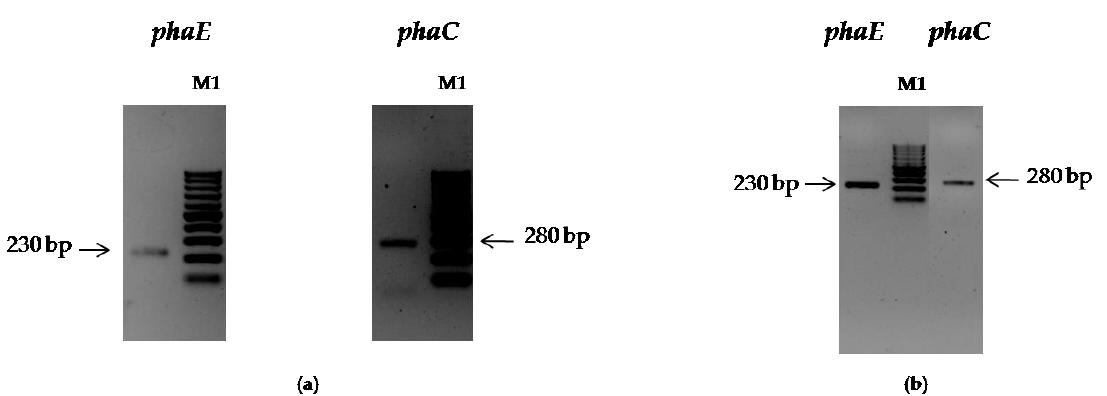
Figure 1. Amplification of the phaE and phaC genes of two strains CEJGTEA101 ( a ) and CEJEA36 ( b ). Lanes M1, 100-bp DNA marker.